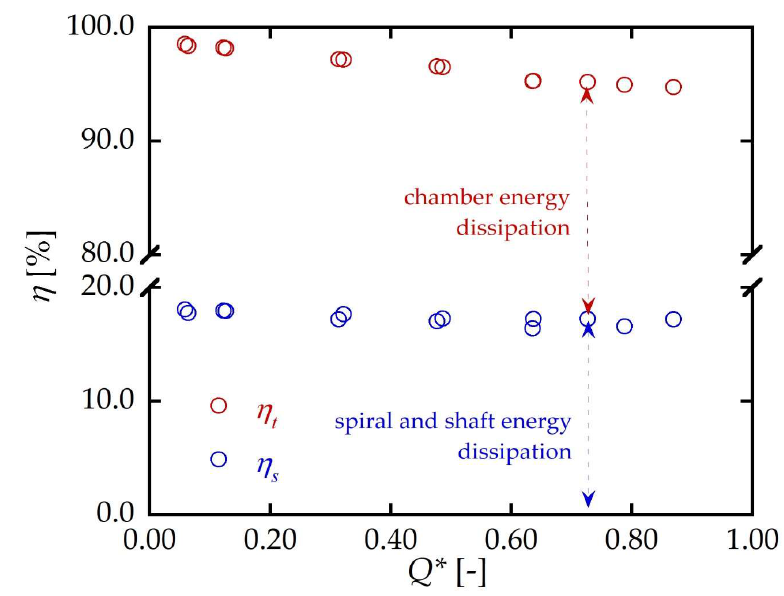
Figure 2. Energy head dissipation efficiency η versus the dimensionless discharge Q* .